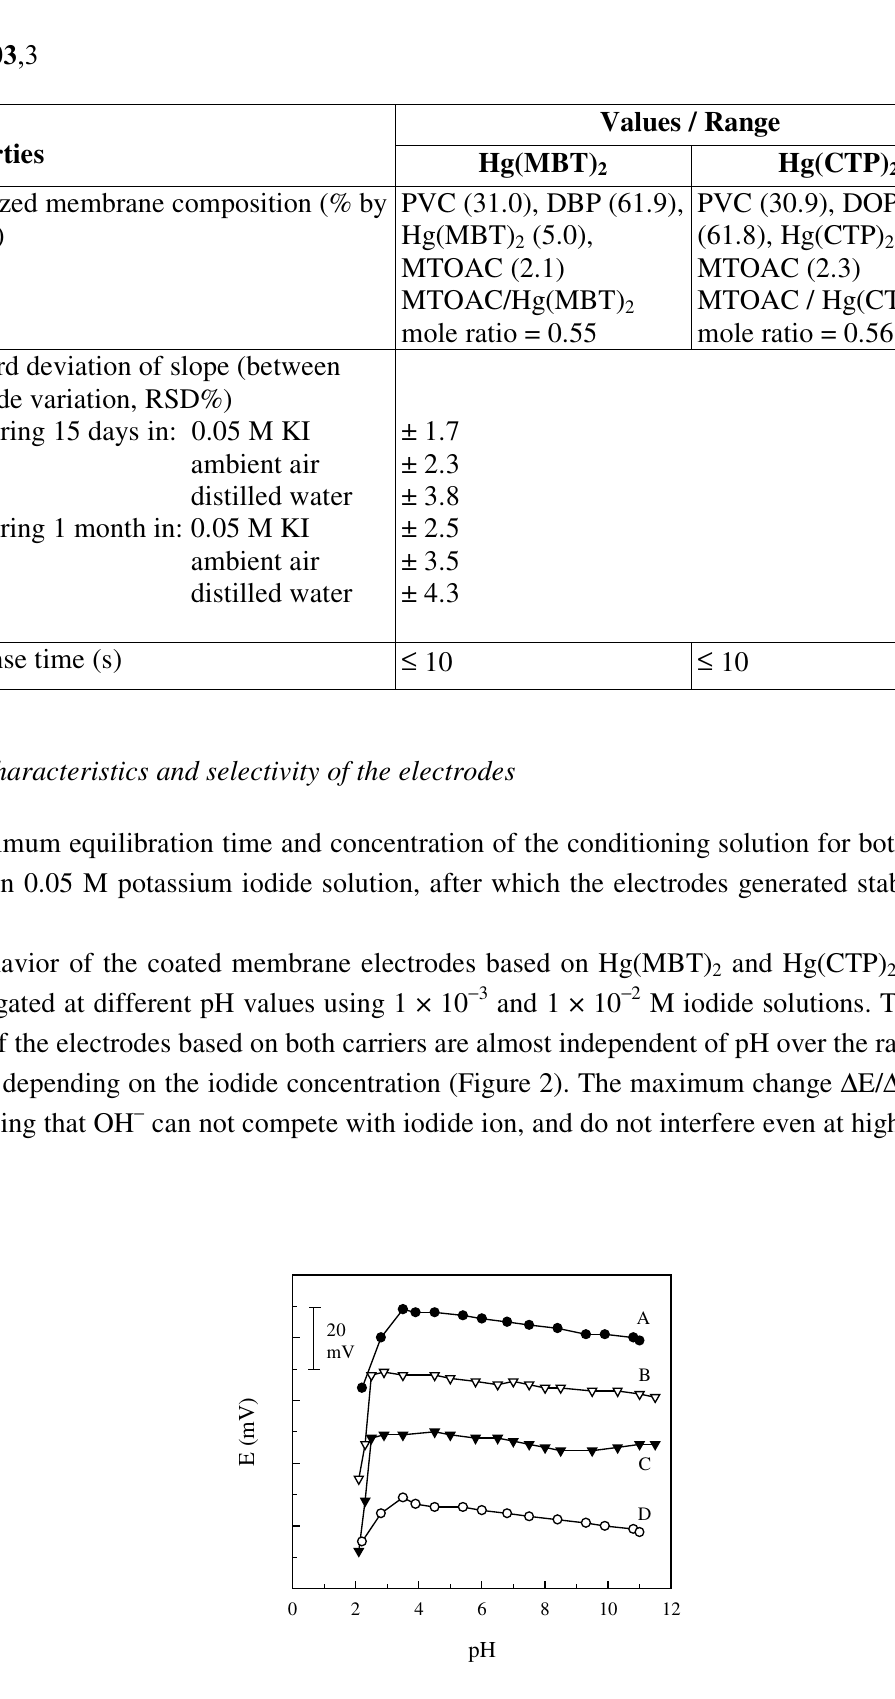
Figure 2. The influence of pH on the potential response of the membrane electrodes based on Hg(CTP) at (A) 1×10 - 3 and (D) 1×10 - 2 M iodide. (C) and (B) are the corresponding 2 curves for Hg(MBT) 2